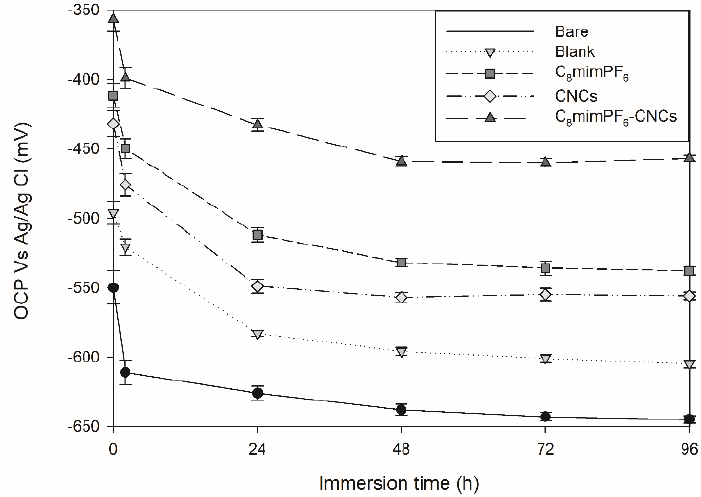
Figure 1. OCP for various samples at different immersion